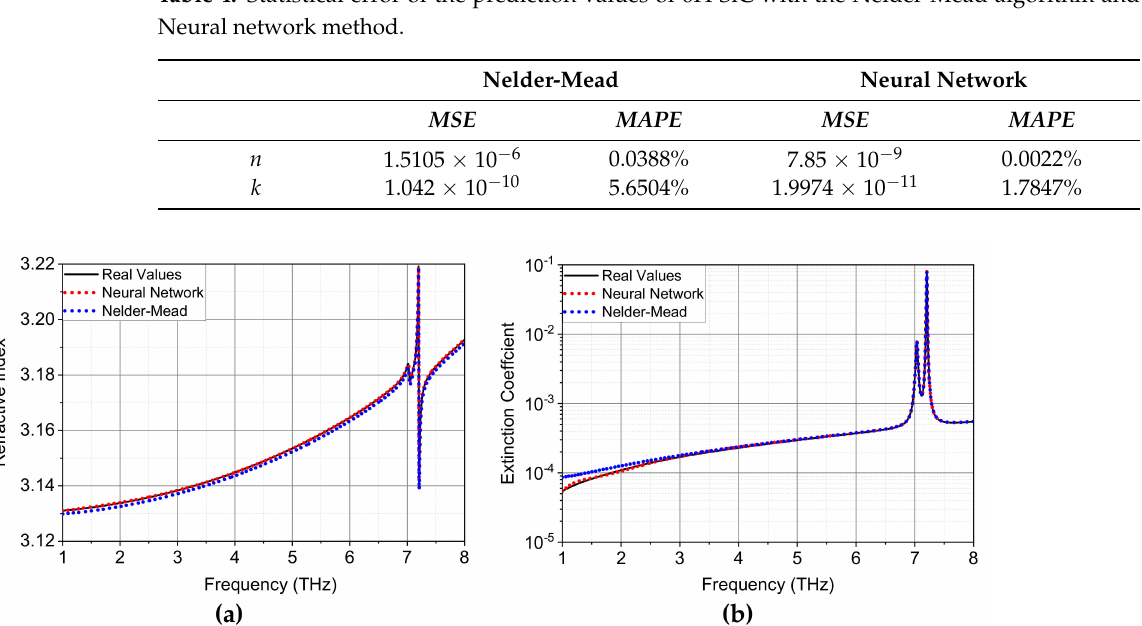
Figure 7. Comparison of extracted optical constants between real values and calculated results with neural network method and Nelder-Mead algorithm for optically thick SiC with a thickness of 0.5 mm: ( a ) refractive index and ( b ) extinction